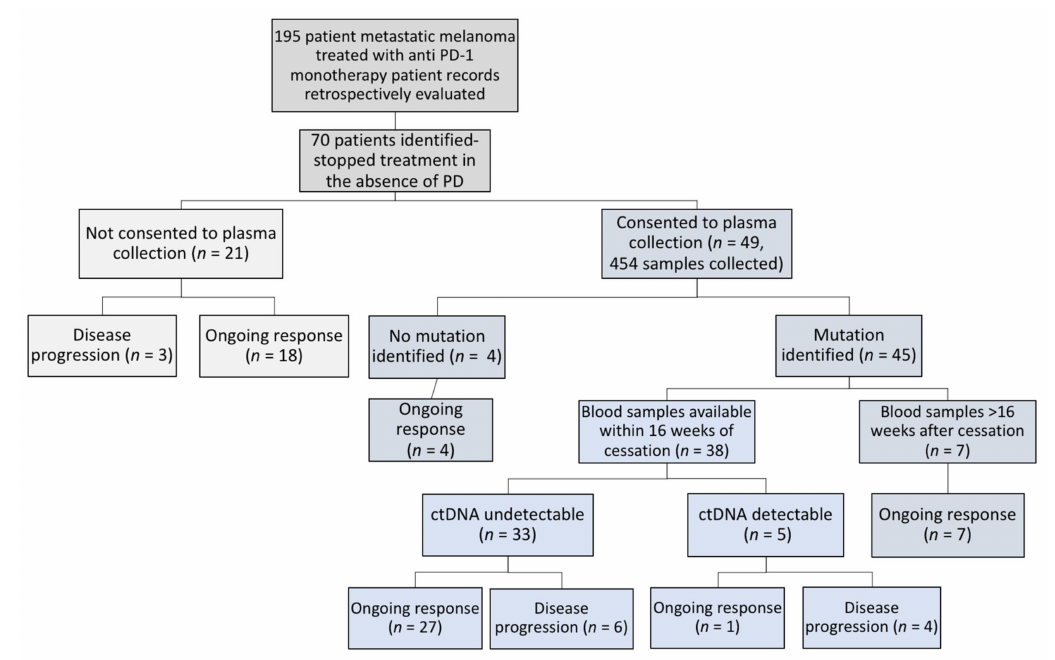
Figure 1. Schema of the 70 patients treated with anti-PD1 therapy and ceased treatment in the absence of disease